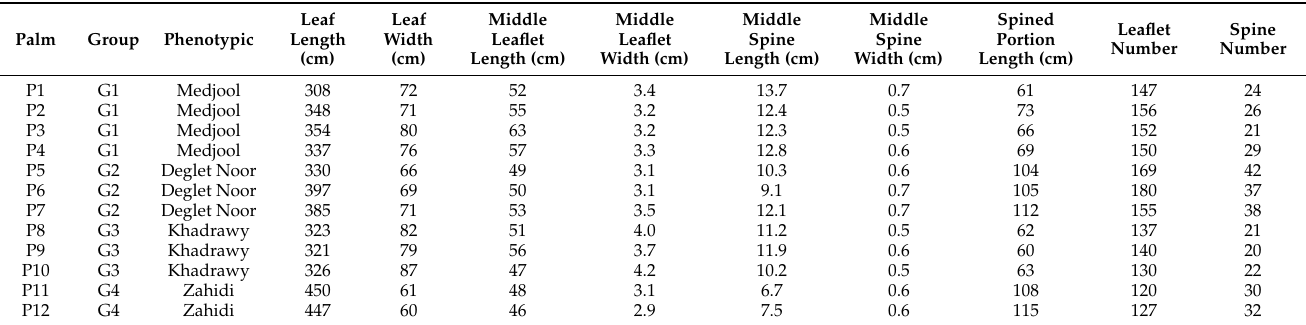
Table 2. Seedling date palm males with similar phenotypic characteristics to four cultivars, which were selected for pollen extraction during the 2021 and 2022 seasons.